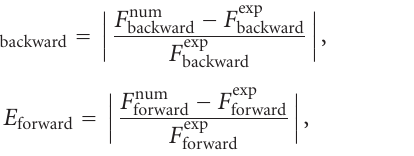
Figure 17: Orbits of the rotor for the first critical speed and the associated deformation of the shaft for (a) configuration B and (b) configuration C